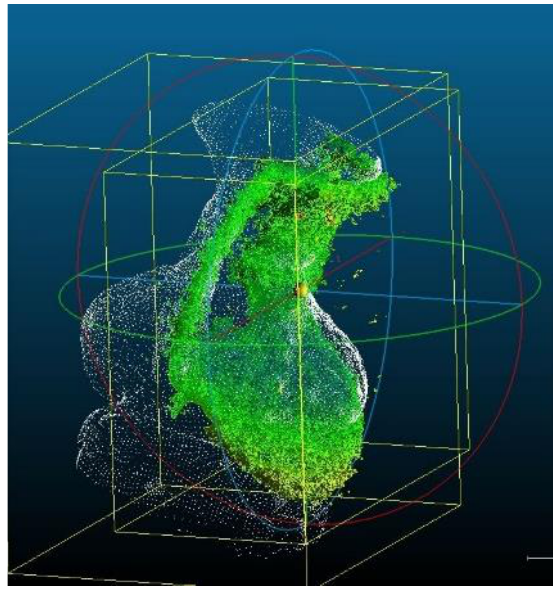
Figure 12. View of merged models after alignment.